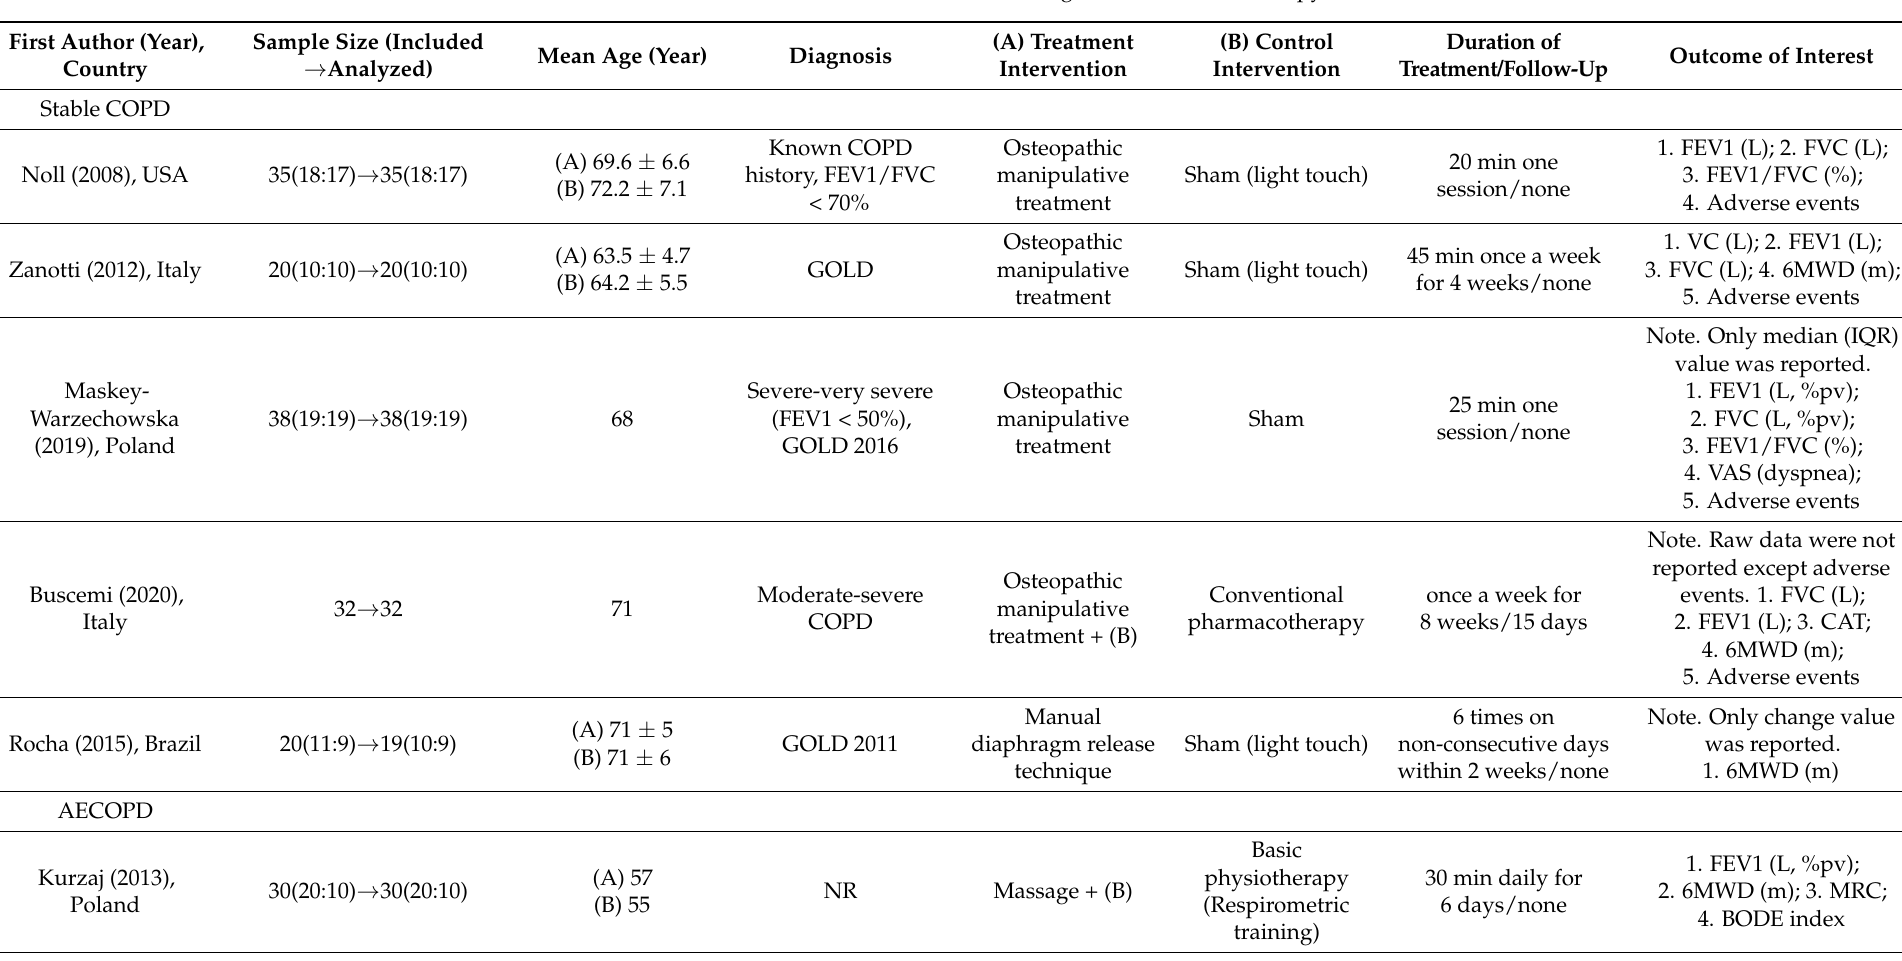
Table 1. Characteristics of included studies using Western manual